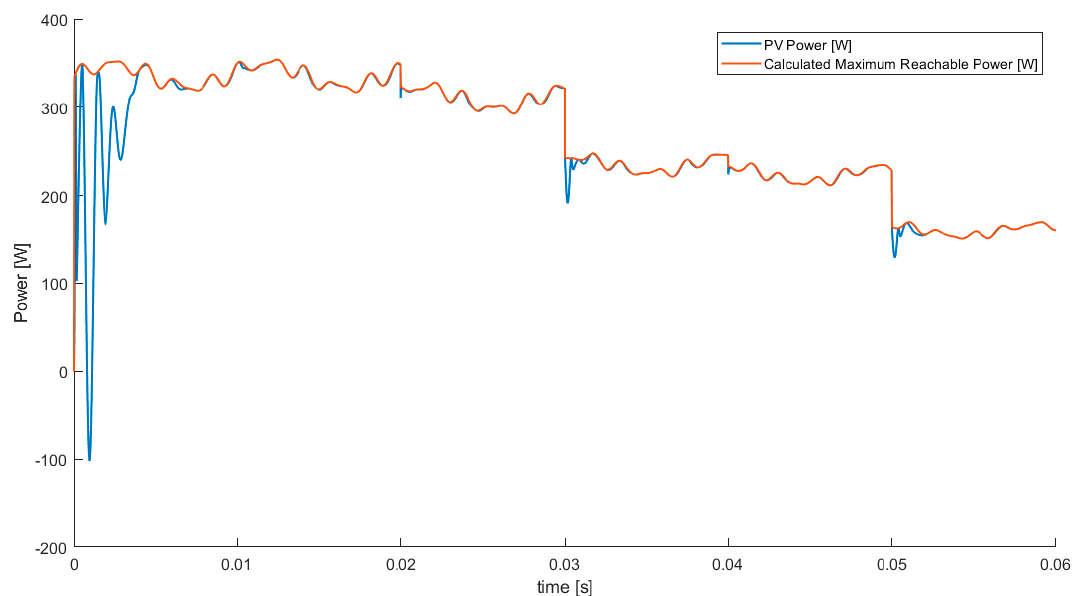
Figure 14. Evolution of PV Power over time.